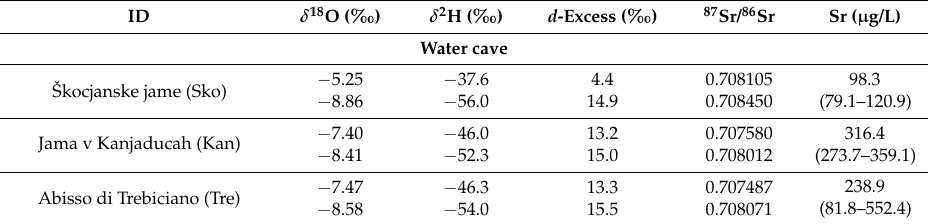
Table 2. Minimum and maximum values of δ 18 O, δ 2 H, d ‐ excess, strontium isotope ratio ( 87 Sr/ 86 Sr). Mean, minimum and maximum Sr content in sampled waters.